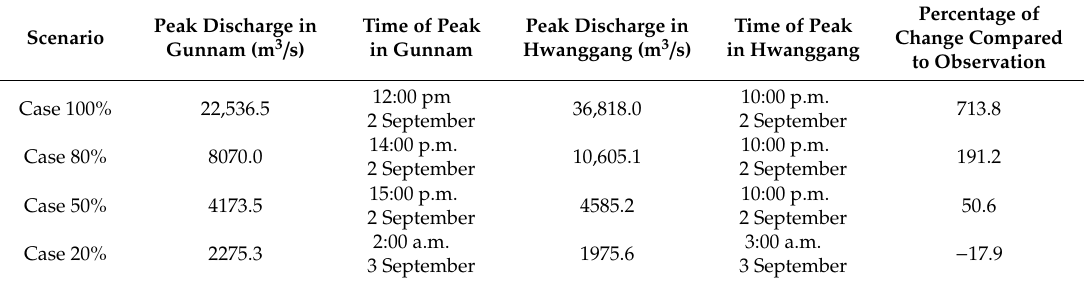
Table 5. Peak discharge and time of peak in Gunnam station and Hwanggang dam in the 2010